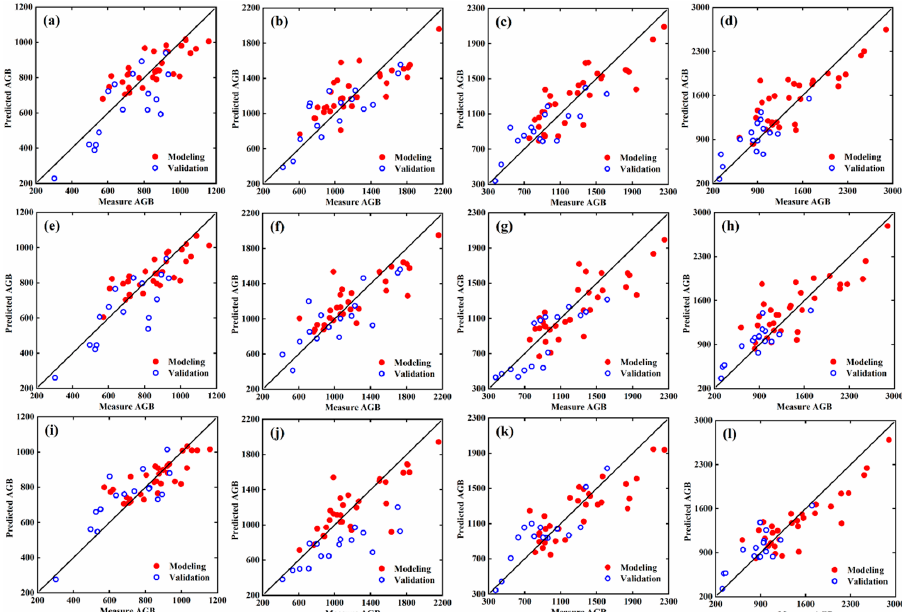
Figure 13. Accuracy of estimating AGB based on the feature variables screened from composite variables by MWPLS, MC-UVE and RF. ( a – c ) The R 2 , RMSE (kg/hm 2 ) and NRMSE (%) of AGB was estimated using the PLSR method. ( d – f ) The R 2 , RMSE (kg/hm 2 ) and NRMSE (%) of AGB was esti- mated using the GPR method.